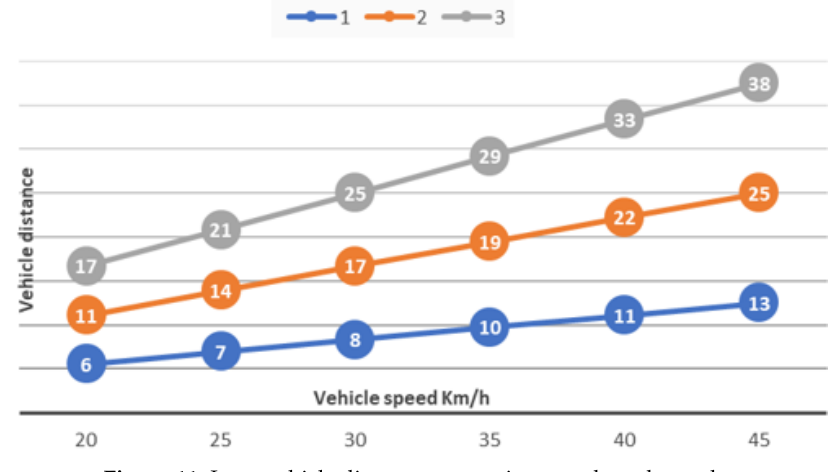
Figure 11. Inter-vehicle distance vs. gap in seconds and